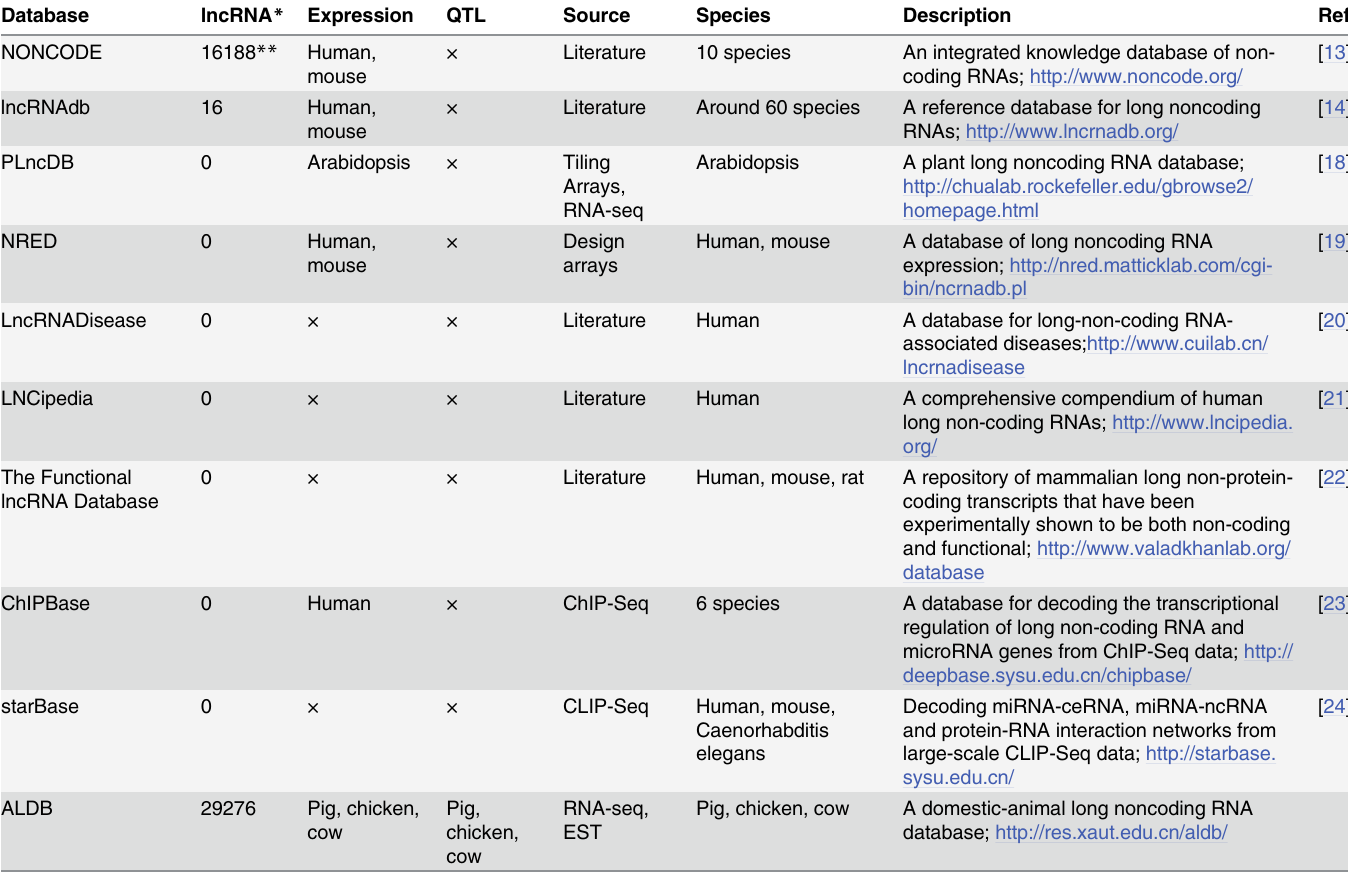
Table 1. Comparison between ALDB and related